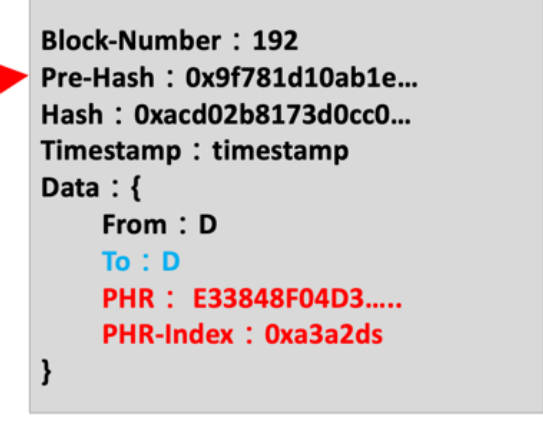
Figure 4. Block content on the blockchain architecture. PHR: personal health